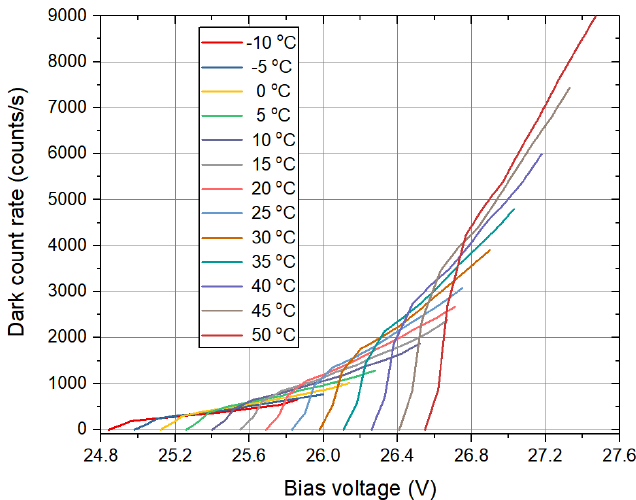
Figure 5. Dark count rate measured on the shaded SPAD under different bias voltages (using bench top instruments) and various temperatures.